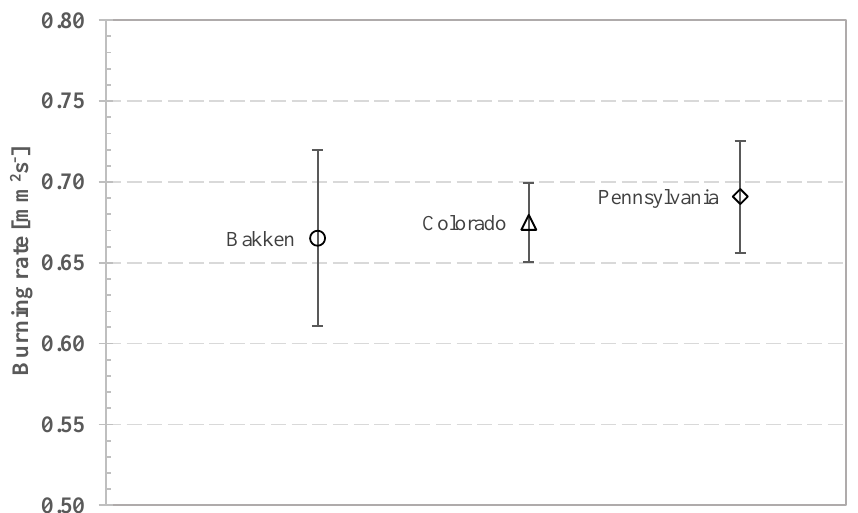
Figure 6. Combustion rates of Bakken, Colorado, and Pennsylvania crude oils in a steady combustion zone.